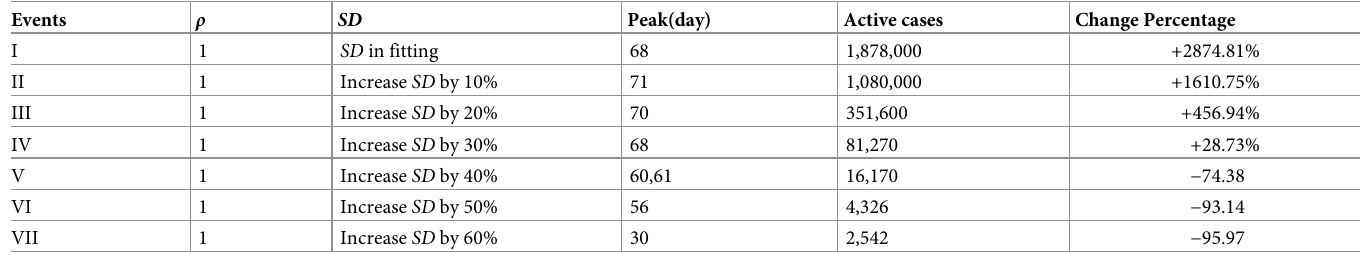
Table 11. Results of different scenarios Second Case, 1 st